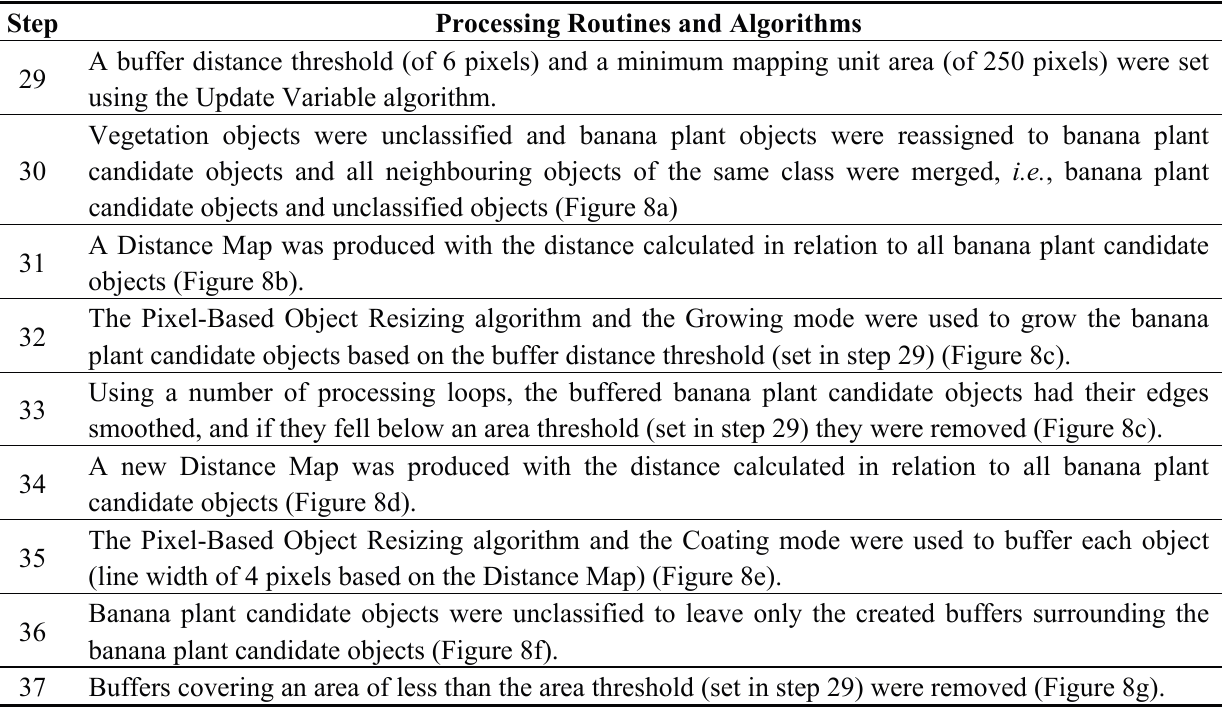
Table 4. Processing routines and algorithms used to create buffers around banana plant